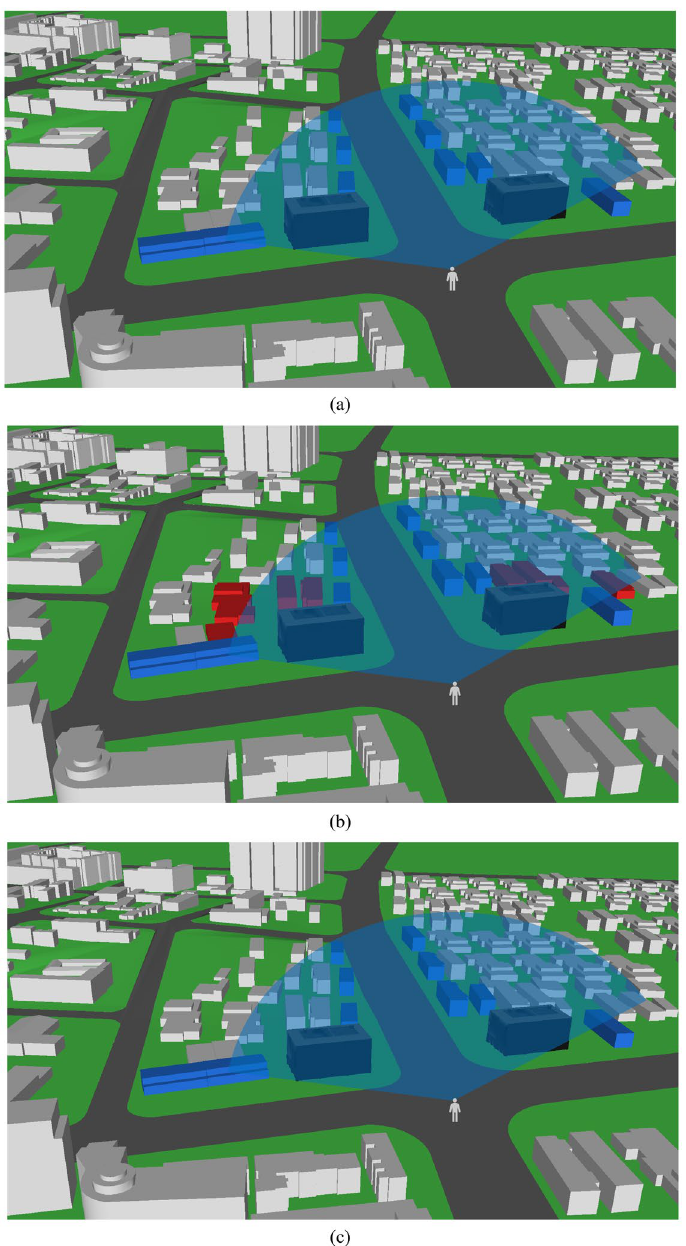
Figure 17. Results of visibility analysis: ( a ) the original model; ( b ) the simplified model of the QEM method; ( c ) the simplified model of the proposed method. The location of the person is the viewpoint, and the light blue fan-shaped area represents the view. The visible buildings using the original model for visibility analysis are marked in blue. In addition, the difference in visible buildings between the model generated by the other methods and the original model is marked in red.